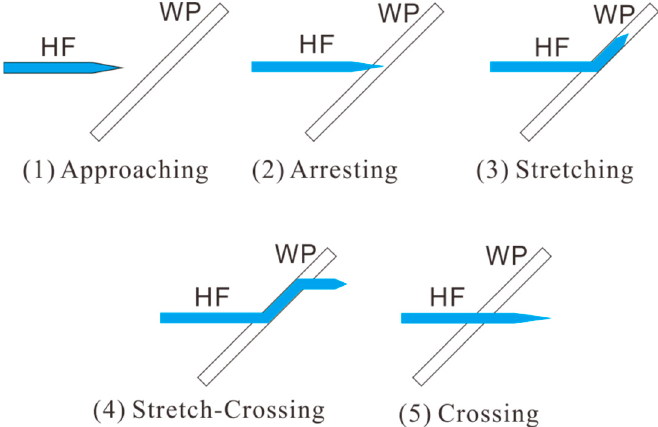
Table 4. Experimental scheme for the study of interactions between hydraulic fractures (HFs) and